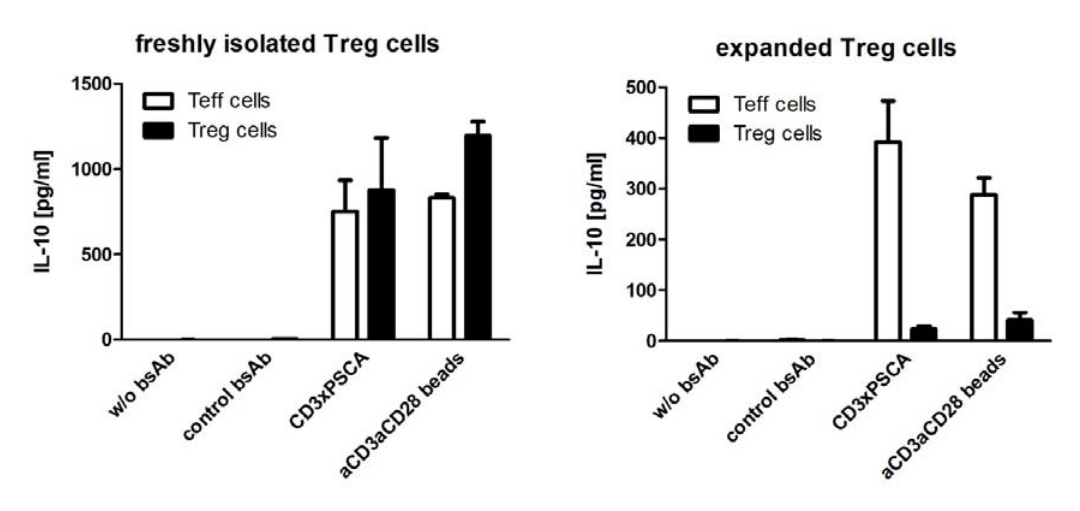
Figure 5. Comparison of IL-10 release from freshly isolated and expanded T cross-linkage with tumor cells via bispecific